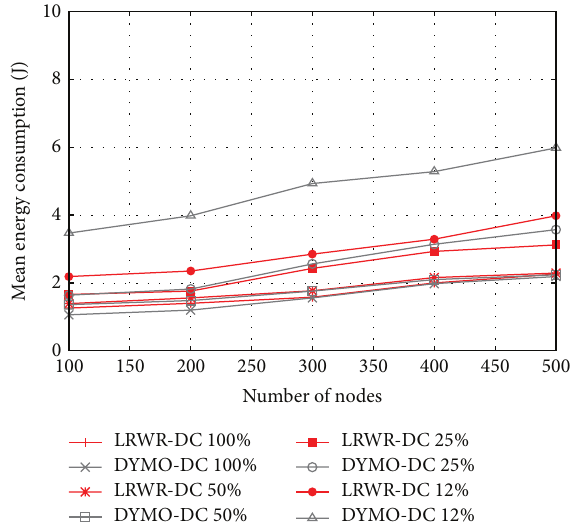
Figure 7: Mean energy consumed versus total number of